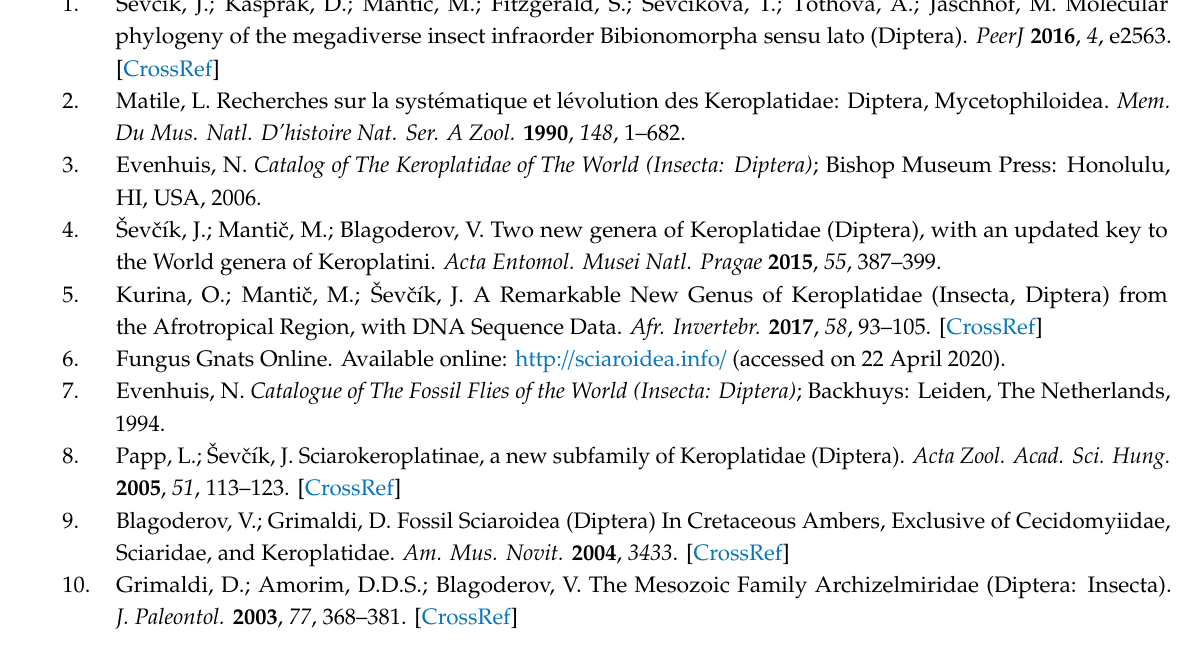
Table S1: List of specimens used for the phylogenetic analysis of Keroplatidae (Diptera) with GenBank accession numbers, Table S2: Primers for PCR amplification and sequencing of the mitochondrial and nuclear gene markers used in this study, Figure S1: Bayesian hypothesis for relationships among selected taxa of Keroplatidae based on DNA sequence data (12S, 16S, 18S, 28S, CAD, COI, cytB, and